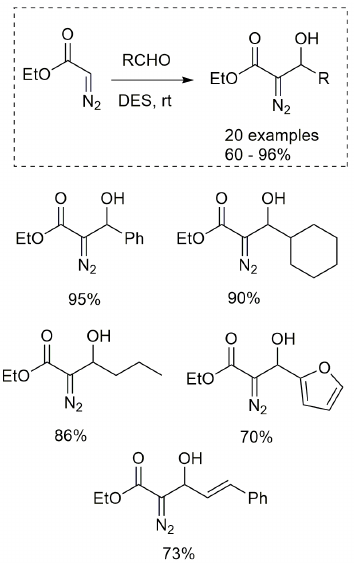
Figure 48 - Base-mediated Aldol-type additions with α-diazocarbonyl compounds.